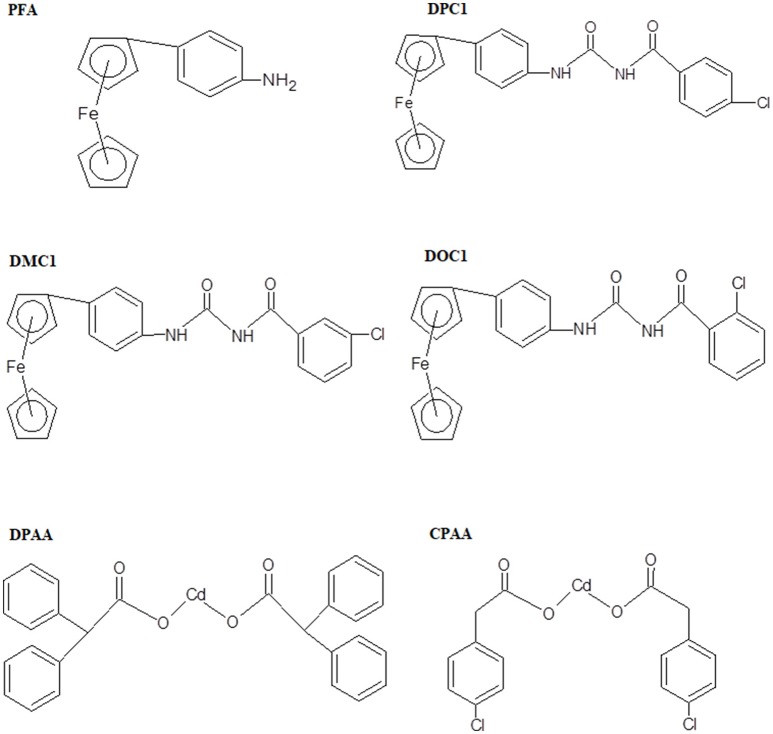
Chemical structures of ferrocene incorporated acyl ureas and homoleptic cadmium carboxylates: 4-ferrocenyl aniline (PFA), 1-(4-chlorobenzoyl)-3-(4-ferrocenylphenyl) urea (DPC1), 1-(3-chlorobenzoyl)-3-(4-ferrocenylphenyl) urea (DMC1), 1-(2-chlorobenzoyl)-3-(4-ferrocenylphenyl) urea (DOC1), bis (diphenylacetato) cadmium (II) (DPAA), and bis (4-chlorophenylacetato) cadmium (II) (CPAA), drawn through Chem. Sketch 2015 2.5 software.